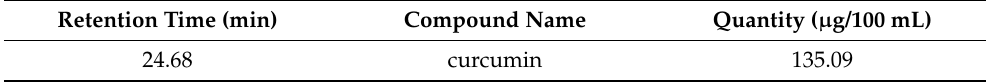
Table 4. Curcuma longa L. glycolic extract